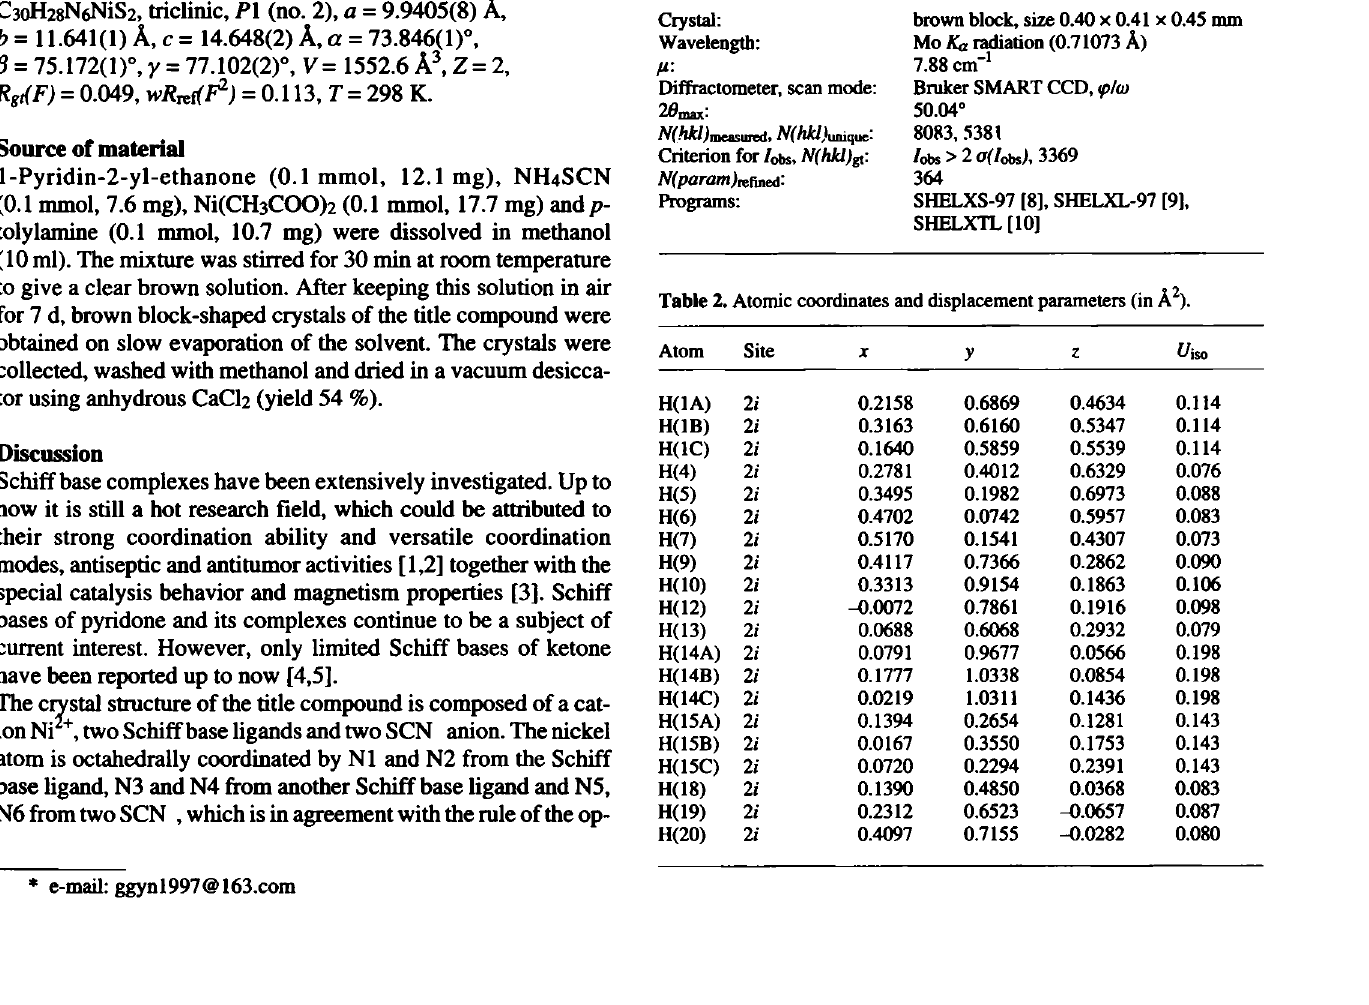
Table 1. Data collection and handling.